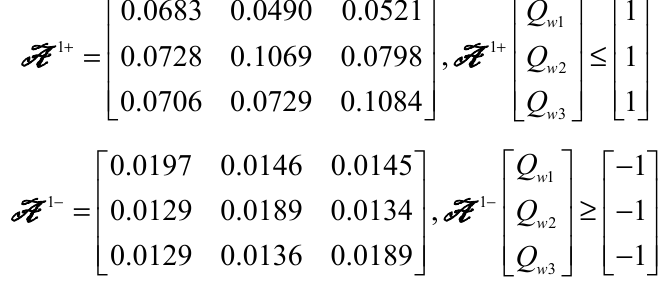
Figure 7. Projection of the normal condition security region on the ( Q